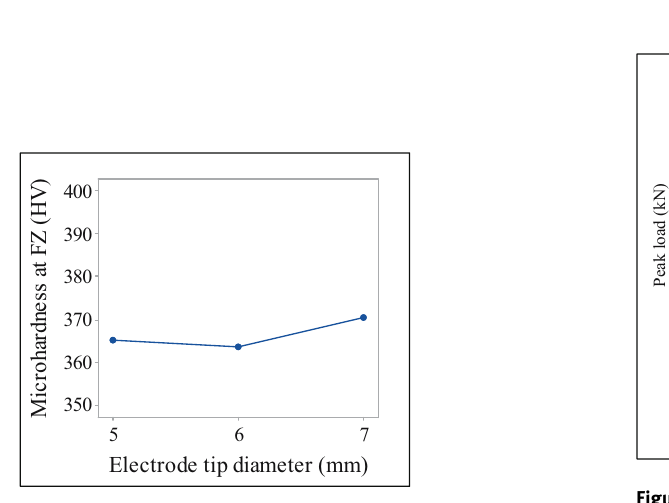
Figure 6: Effect of electrode tip diameter on microhardness of FZ.